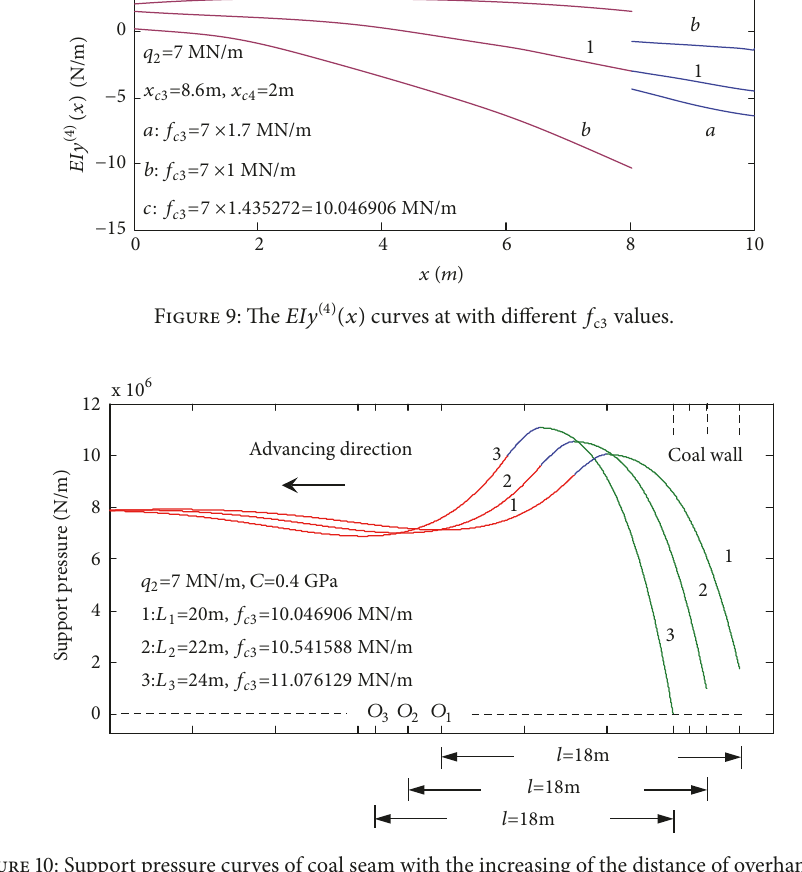
Figure 10: Support pressure curves of coal seam with the increasing of the distance of overhang